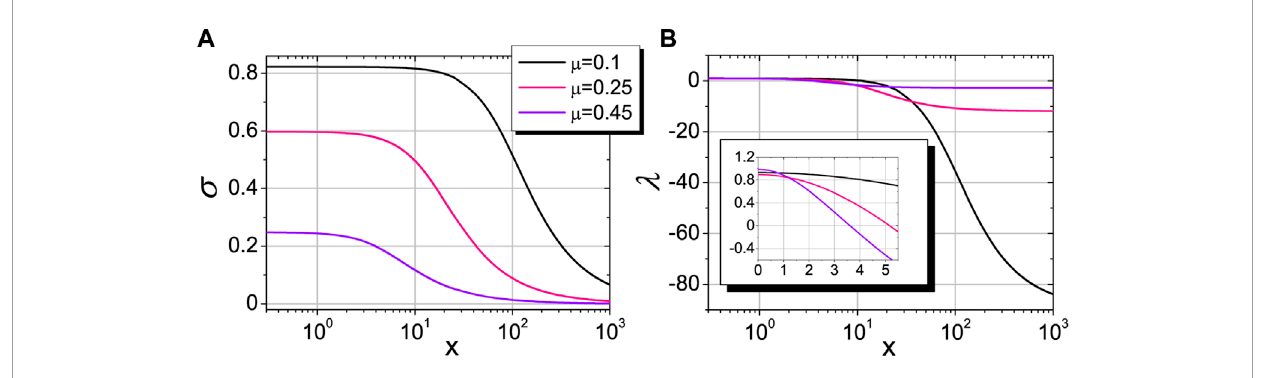
FIGURE 2 Functions σ ( x ) (A) and λ ( x ) (B) in a wide range of variable x and at fixed μ .